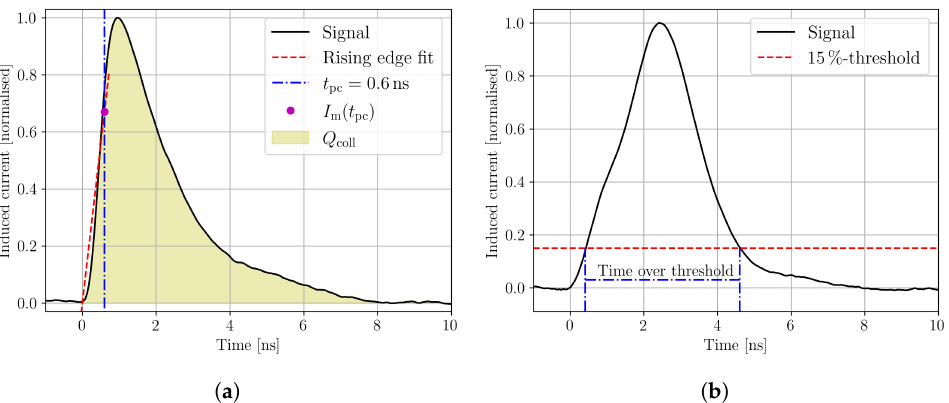
Figure 3. Examples of the induced current signal with corresponding analysis to extract the start time, the prompt current, and the collected charge ( a ) and the time over threshold ( b